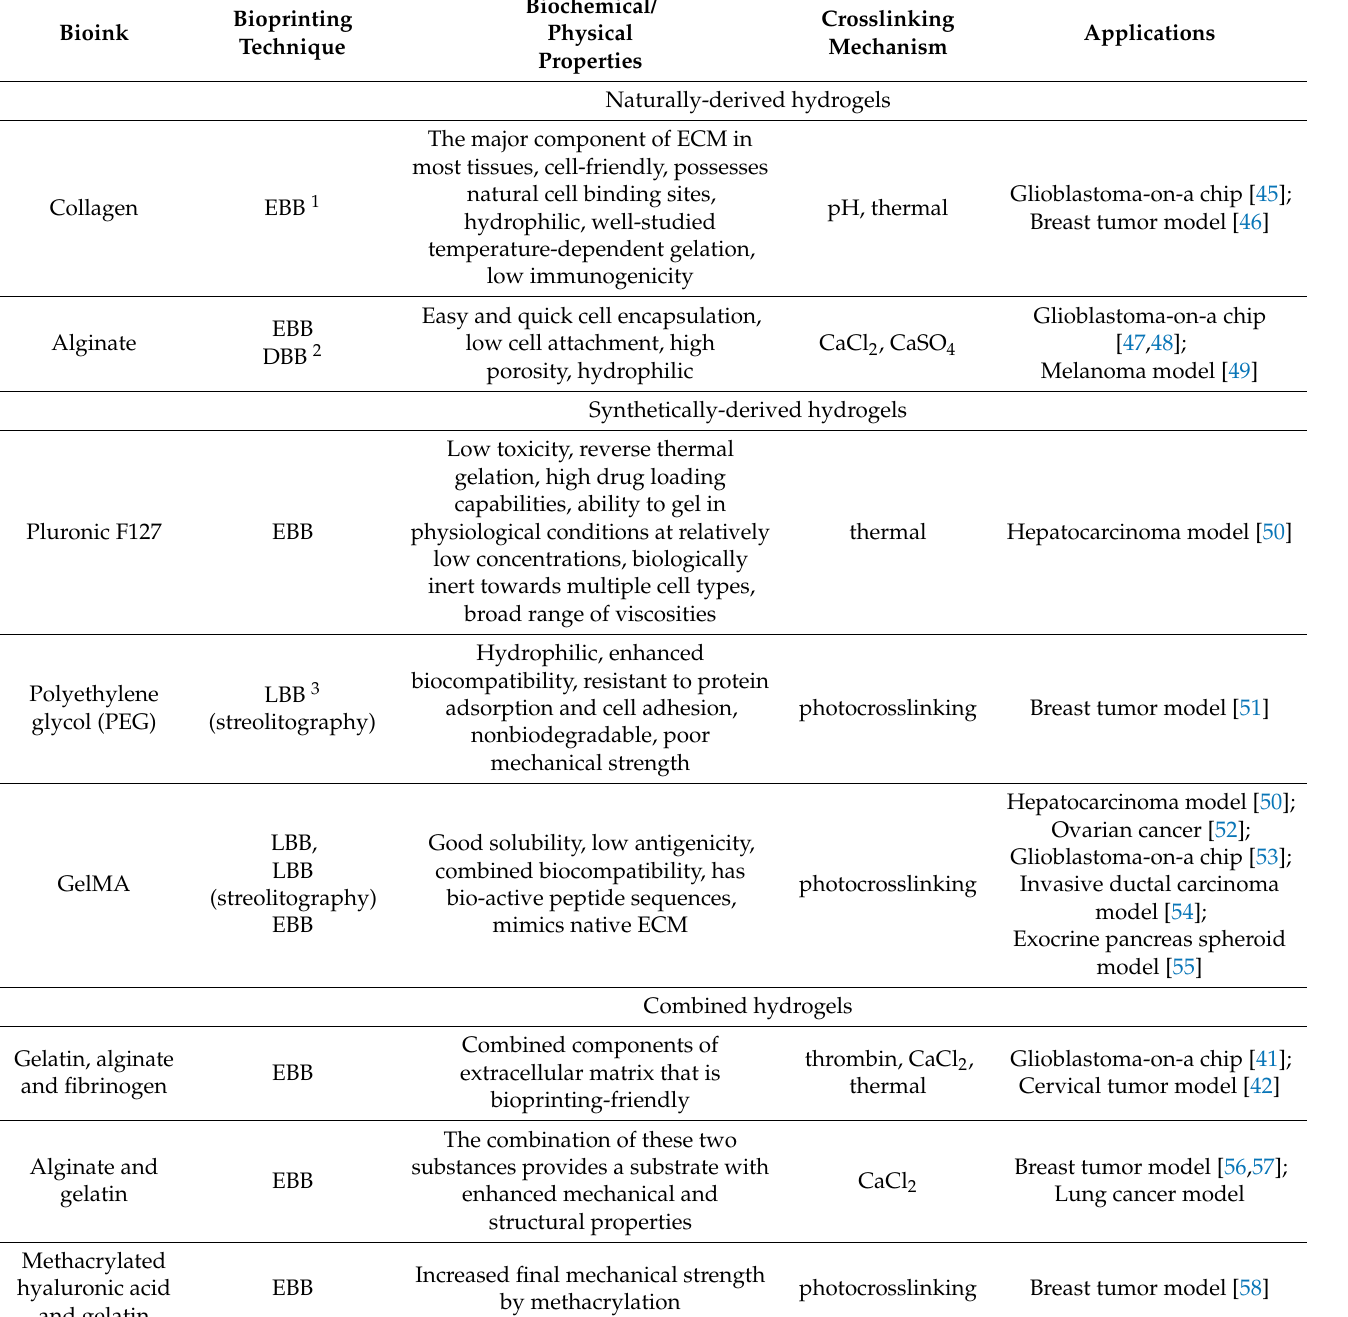
Table 1. Examples of applications of bioinks in 3D-bioprinting models of